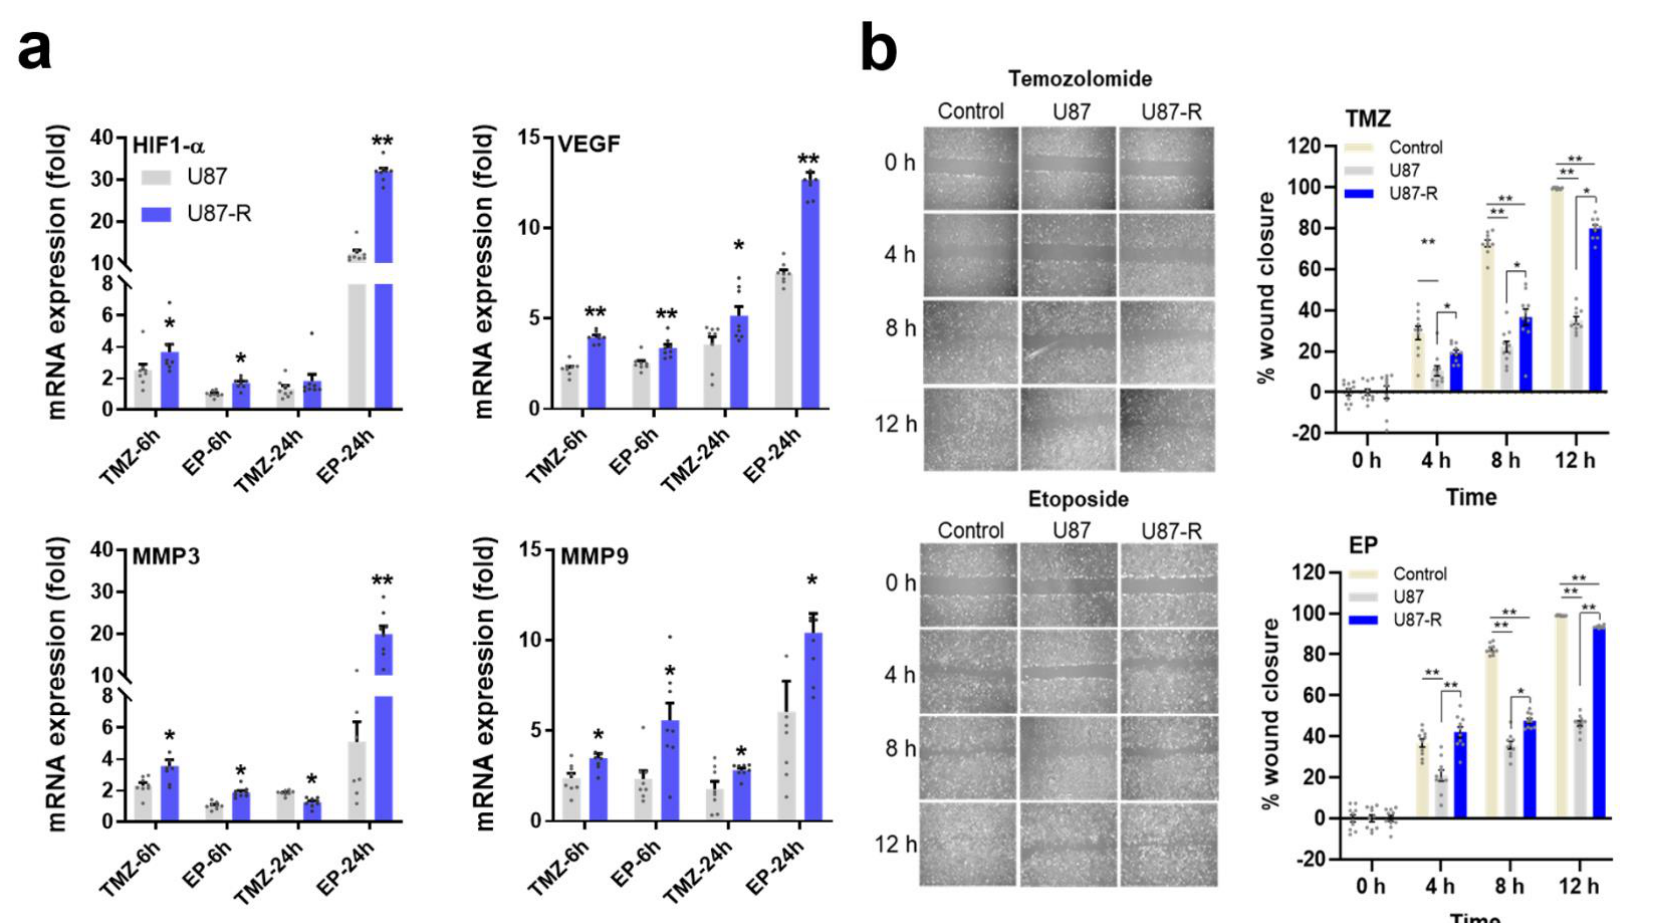
Figure 7: a ) Relative fold change of VEGF , HIF1-α , MMP3 , and MMP9 in EP- and TMZ-treated U87-R and U87 cells as determined by quantitative real-time PCR. All data were normalized to β-actin and GAPDH and are given relative to control (control=1, not shown in figure). Data are presented as mean ± SE. n=8 *indicates significantly different values in U87-R vs U87 groups, Mann-Whitney U test: * p ≤0.05; ** p ≤0.01 b) Cell migration and wound closure as determined by wound healing assay (for 2, 4, 8, and 12 h) in TMZ- or EP-treated resistant U87-R and non-resistant U87 cells. Data are presented as mean ± SE. n=10 *indicates significantly different values in U87-R vs U87 groups, oneway-ANOVA, Tukey HSD test *p ≤0.05; ** p ≤0.01; Control: Vehicle-treated control, TMZ: temozolomide IC : 250.2 μM, etoposide IC : 6.49 50 50